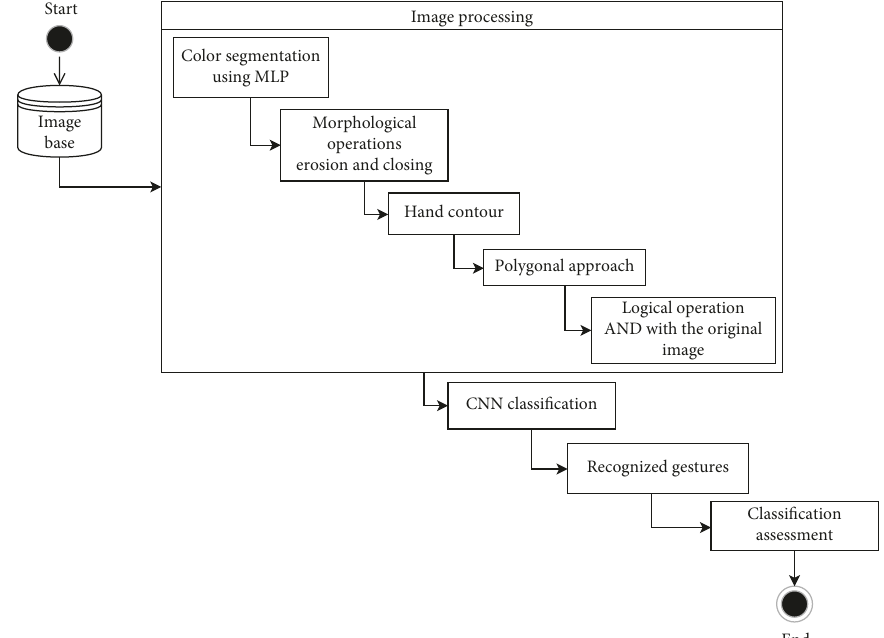
Figure 3: The sequence of processes in our methodology.